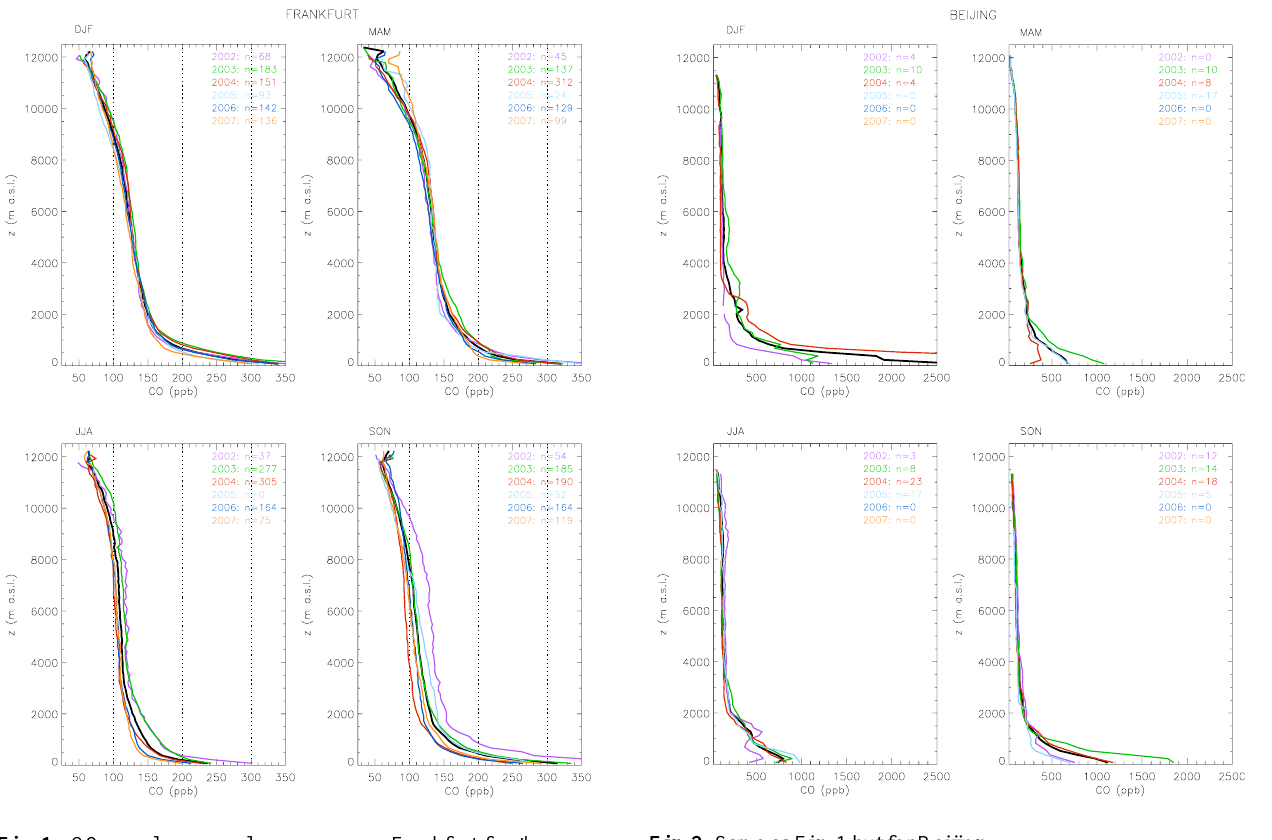
Fig. 1. CO profile seasonal averages over Frankfurt for the years 2002–2007. n is the number of flights during the season. The black line is the average for all years.